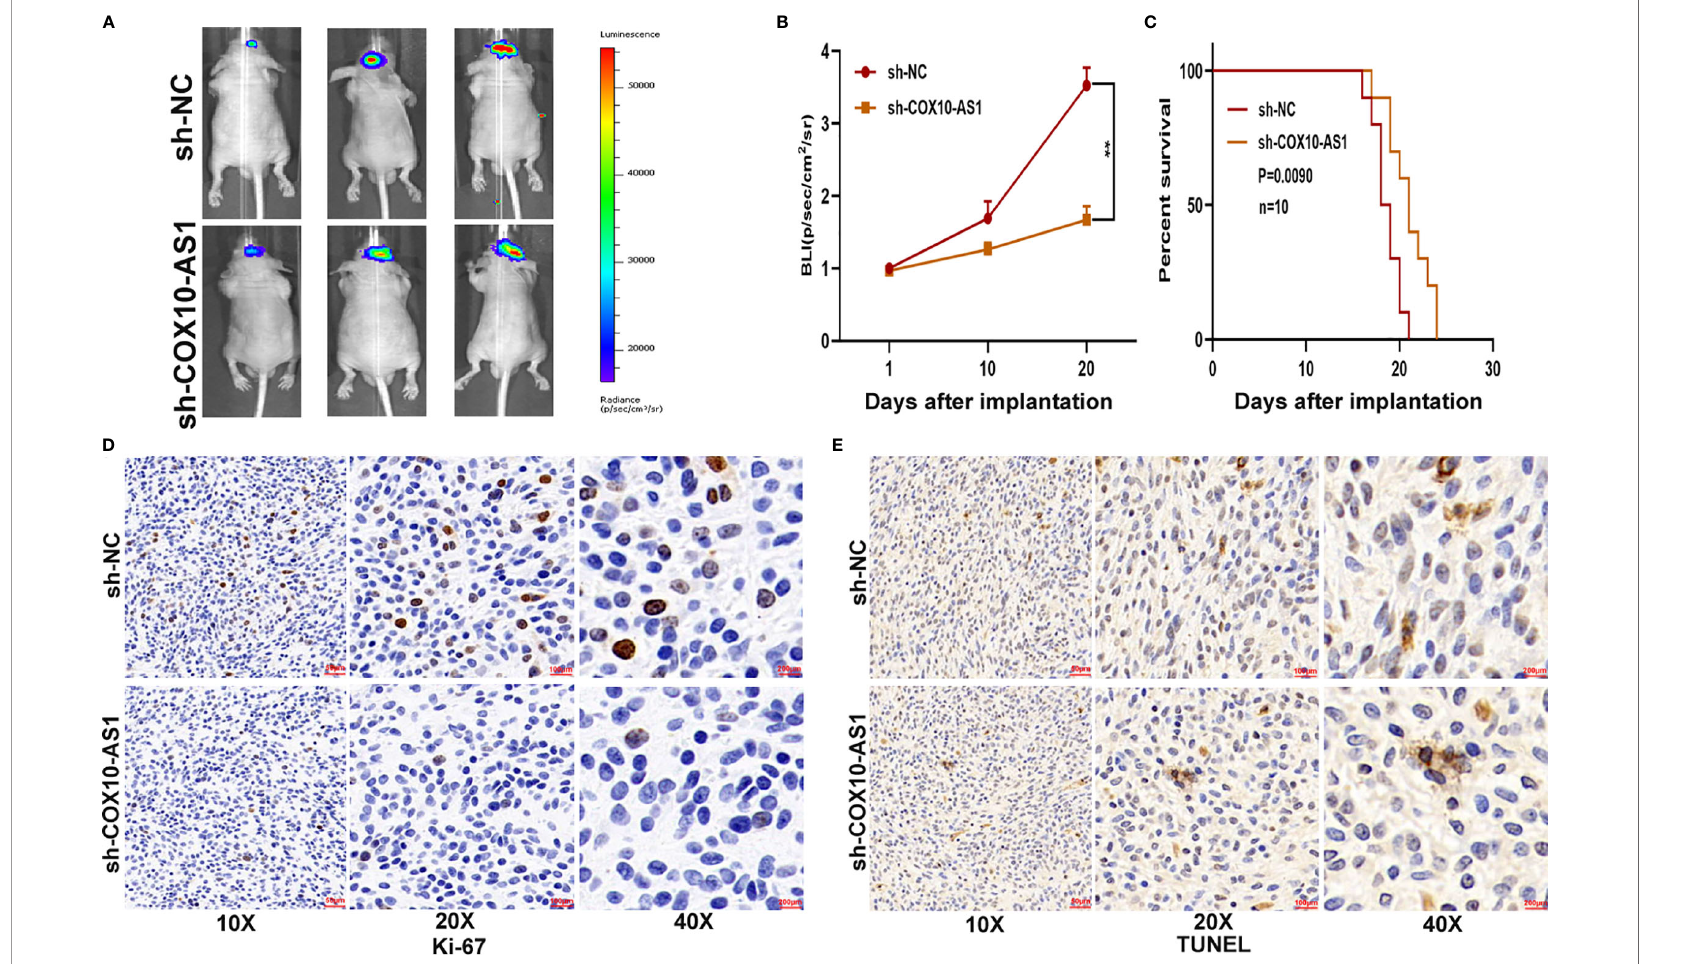
FIGURE 3 | COX10-AS1 promotes glioma growth in vivo . (A, B) The bioluminescent images of the tumours formed in the brains of nude mice were acquired at days 1, 10 and 20 after implantation. (C) Overall survival was compared between the sh-COX10-AS1 and sh-NC groups by Kaplan-Meier survival curves. (D) Immunohistochemistry for Ki-67 in the sh-COX10-AS1 and sh-NC groups. (E) TUNEL staining in the sh-COX10-AS1 and sh-NC groups. **P <